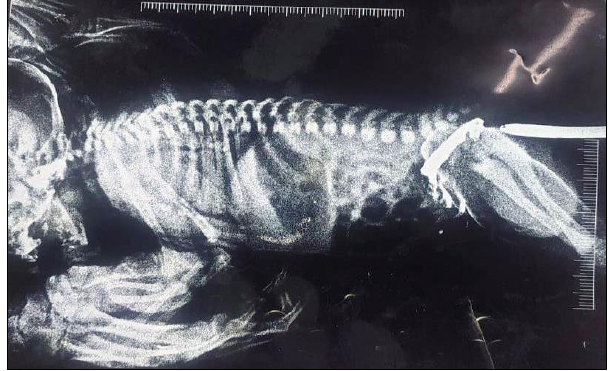
Figure 1: Prone cross-table lateral x-ray showing distal colostogram with a metallic probe in anal canal